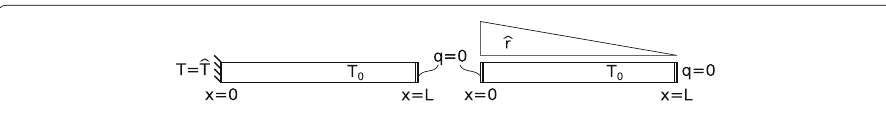
Fig. 5 Geometry, thermal loads, boundary and initial conditions for solidification front example (left) and melting volume example (right)